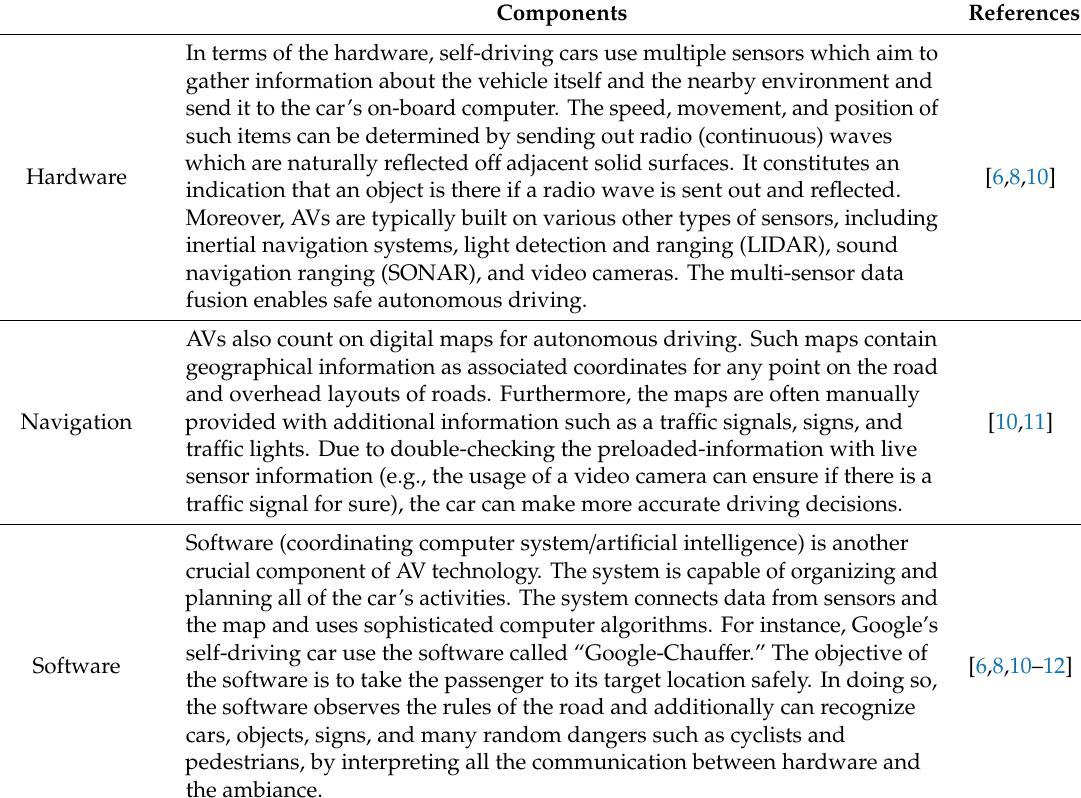
Table 1. Components of autonomous vehicles